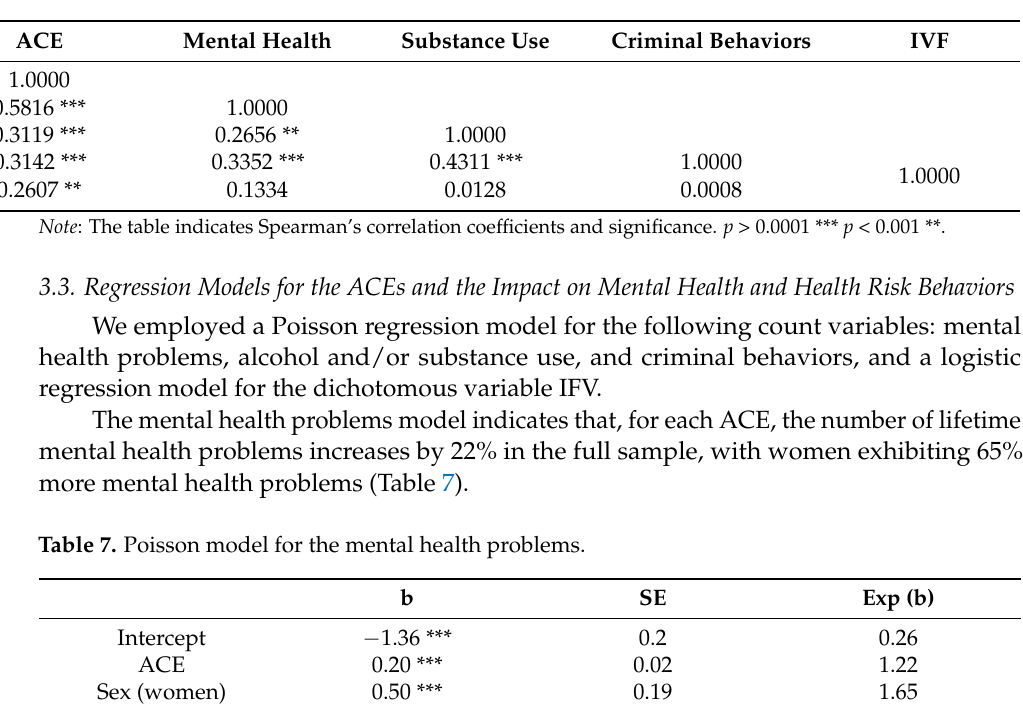
Table 6. Correlation between ACEs and impact on mental health, criminal behaviors, alcohol and/or substance use, and IFV in women.